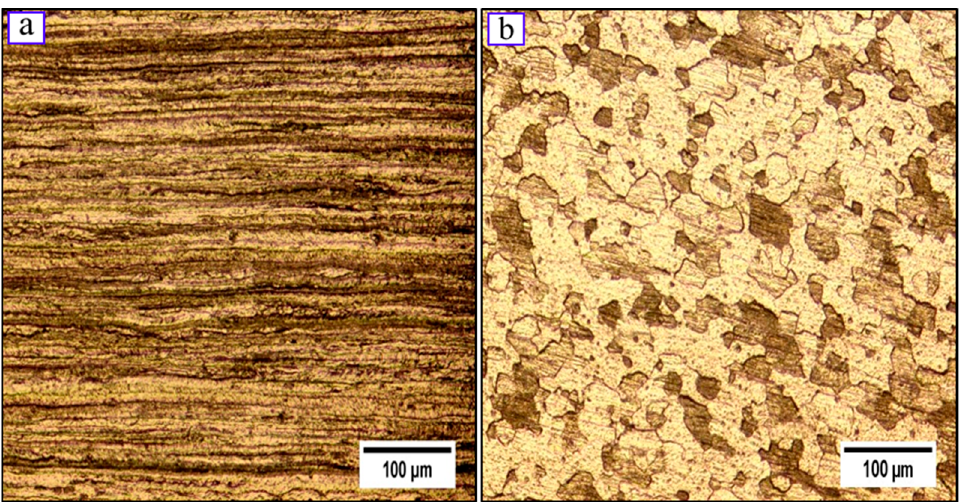
Figure 2. Microstructure image of the base metal: ( a ) in the rolling direction, ( b ) perpendicular to the rolling direction.